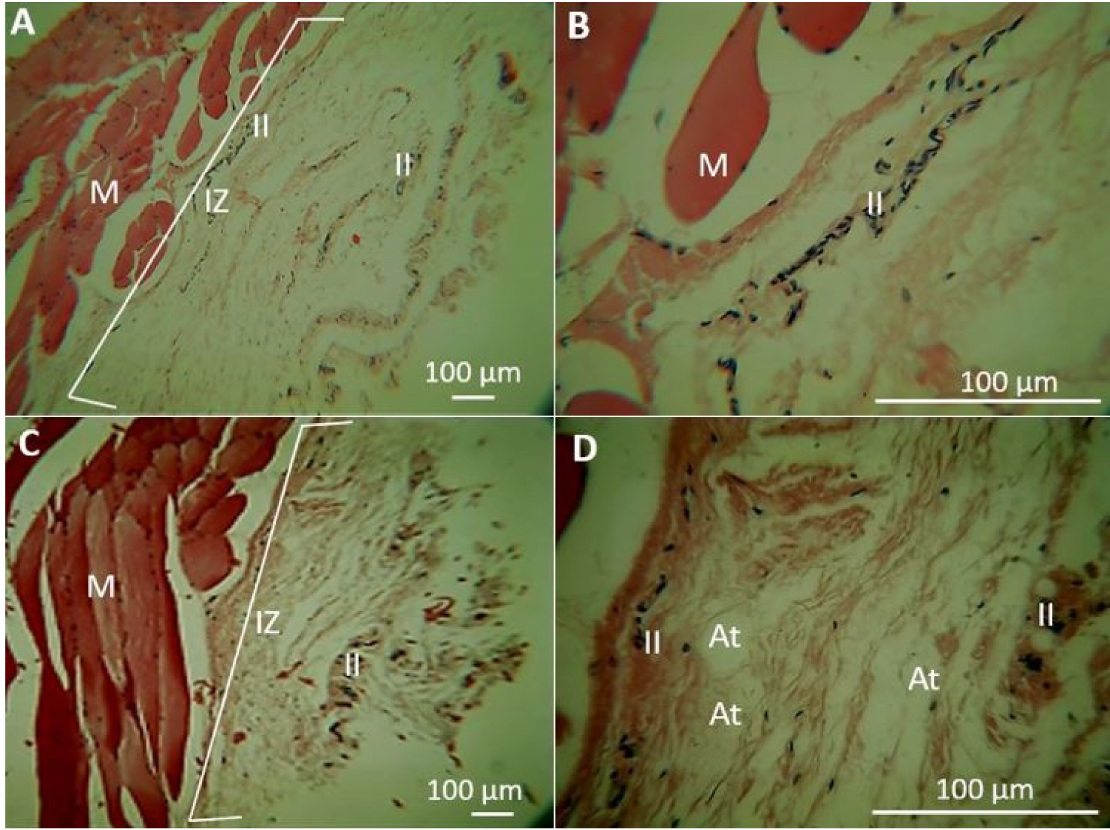
Figure 11. Porcine collagen (Control) implanted in the Wistar rat subdermal area for 30 and 90 days. ( A , B ) correspond to implantation at 30 days, ( C , D ) to implantation at 90 days. ( A , C ) at 10 × . ( B , D ) at 40 × . IZ. Implantation area. II: Inflammatory infiltrate. M: Muscle. At: adipose tissue. Hematoxylin Eosin Technique